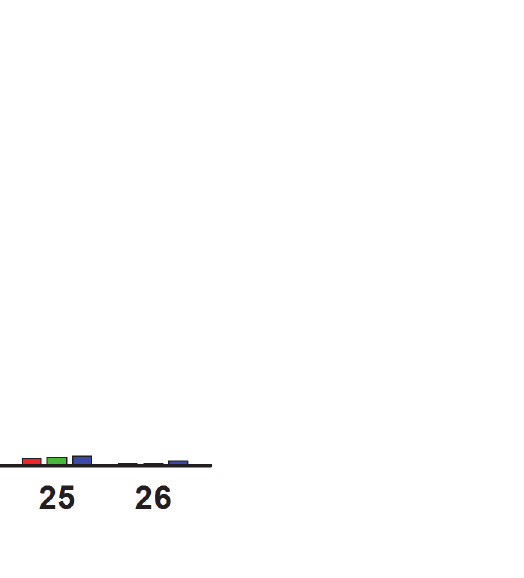
Fig 1. Lengths of unique small RNA sequences in chrysanthemum.